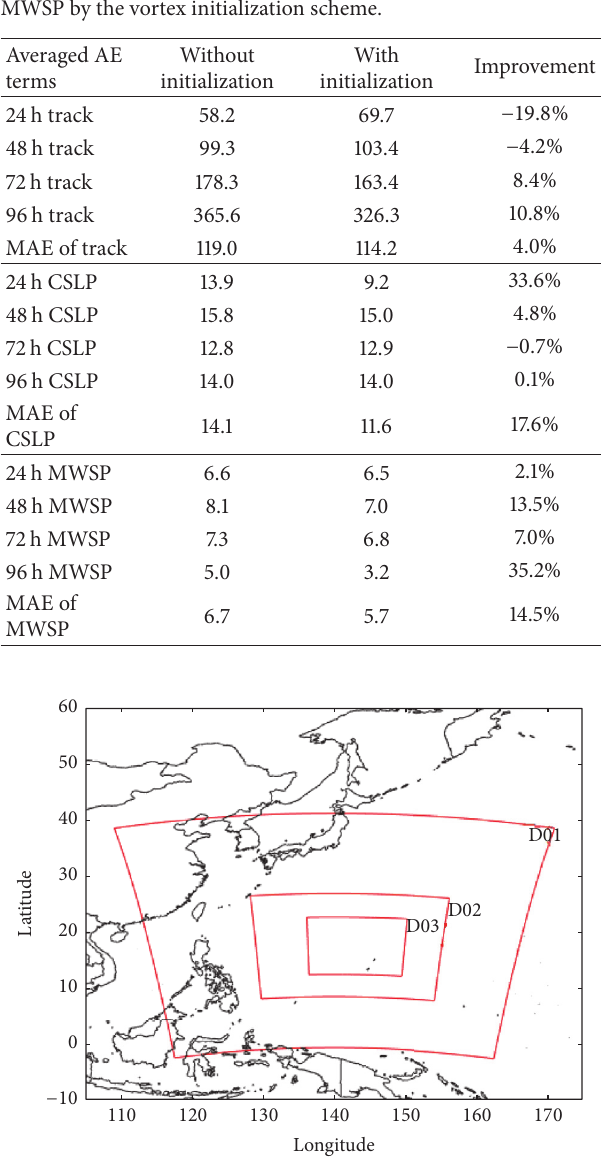
Table 2: Configurations in the vortex initialization scheme.